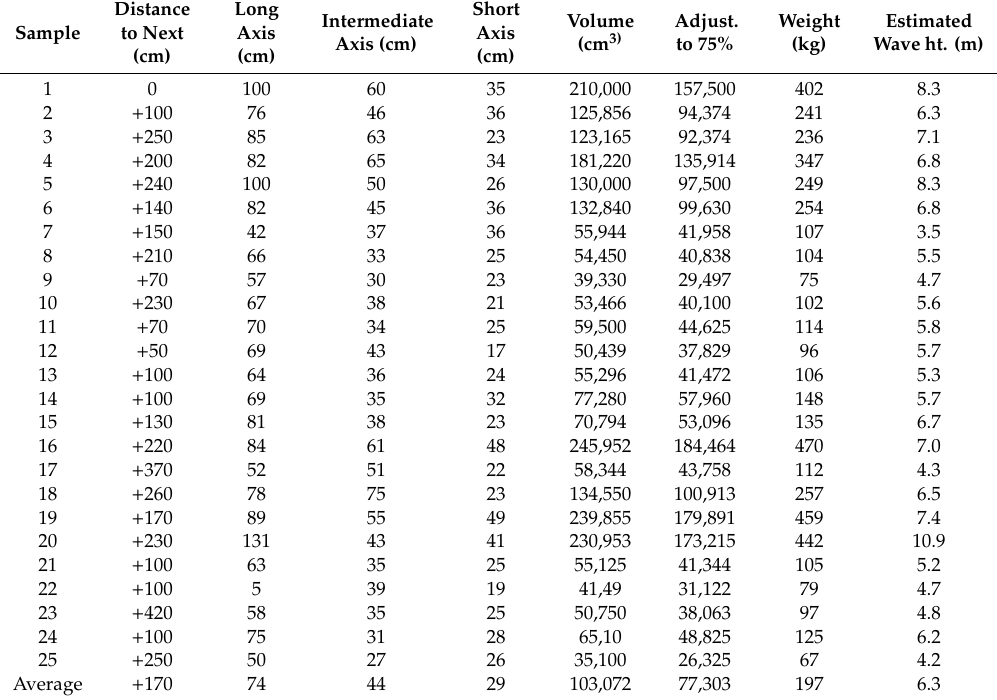
Table 1. Quantification of boulder size, volume and estimated weight from coastal bar samples through Transect 1a at the east end of Cerro El Chino (Puerto Escondido). The laboratory result for density of andesite at 2.55 gm / cm 3 is applied uniformly in order to calculate wave height for each boulder.